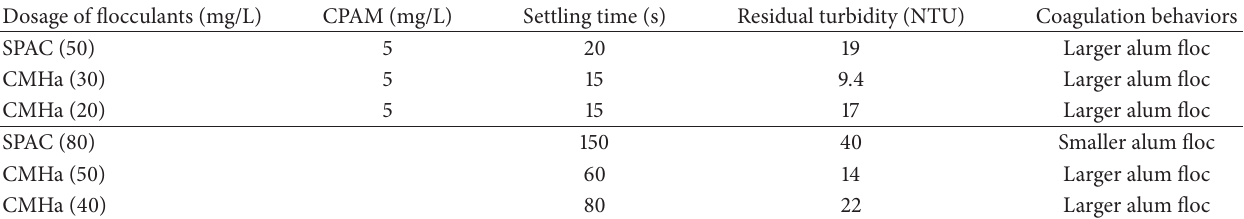
Table 15: Coagulation behaviors of CMHa versus PAC for coal-washing wastewater treatment (original wastewater 1200NTU). Dosage of flocculants